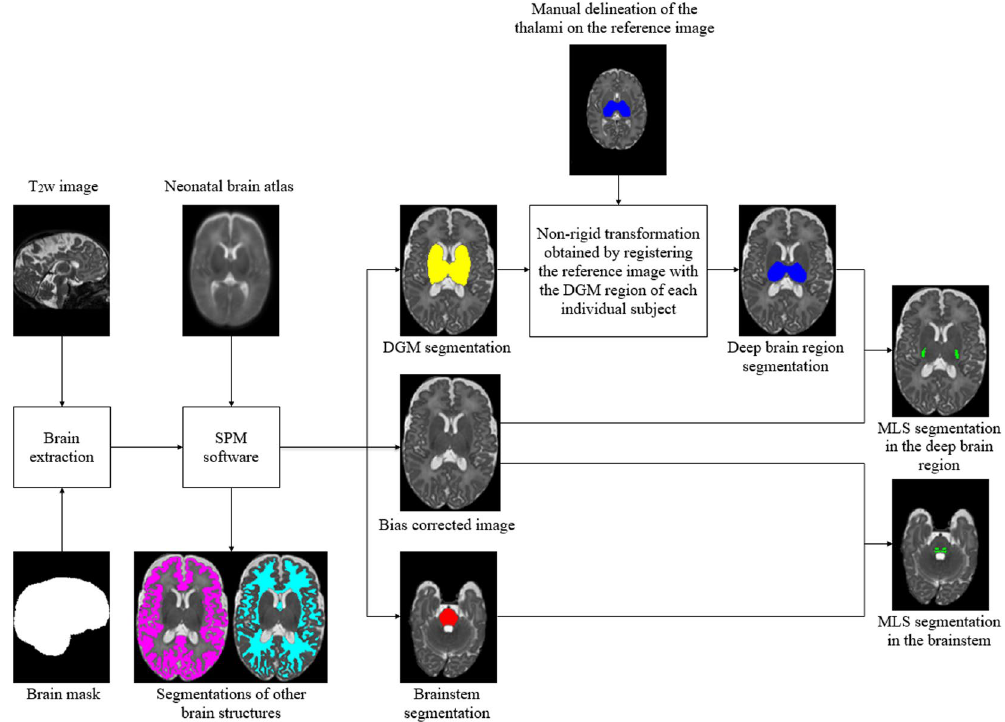
Figure 5. Schematic flow of the proposed segmentation approach for myelin-like signals (MLS) on T 2 -weighted neonatal brain images. Through image preprocessing, we achieve brain extraction and bias field correction, and obtain the binary masks of the deep brain region and brainstem for individual subjects. The automatic segmentations of the deep gray matter (DGM), obtained using the Statistical Parametric Mapping (SPM) software, contain the basal ganglia, thalami, hippocampi and amygdalae. We extract the masks for the deep brain region from the DGM segmentations via label